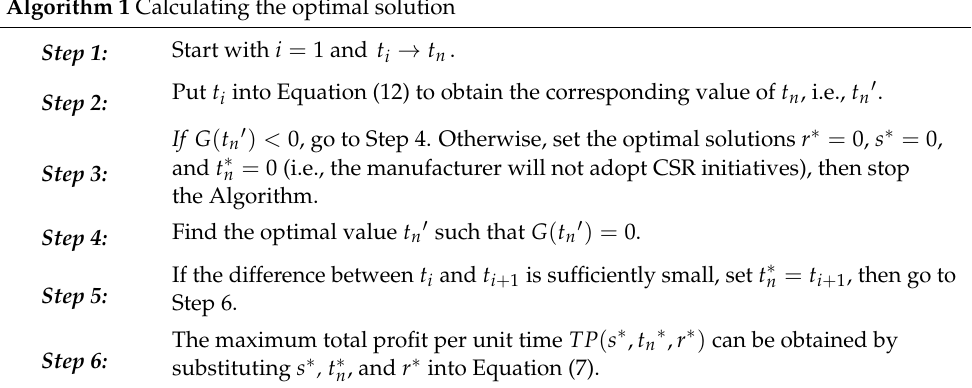
Algorithm 1 Calculating the optimal